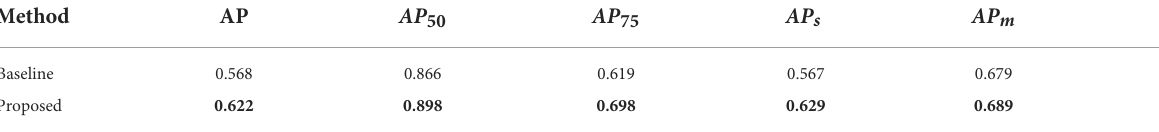
TABLE 3 Performance of the baseline method and the proposed algorithm on HRSID.